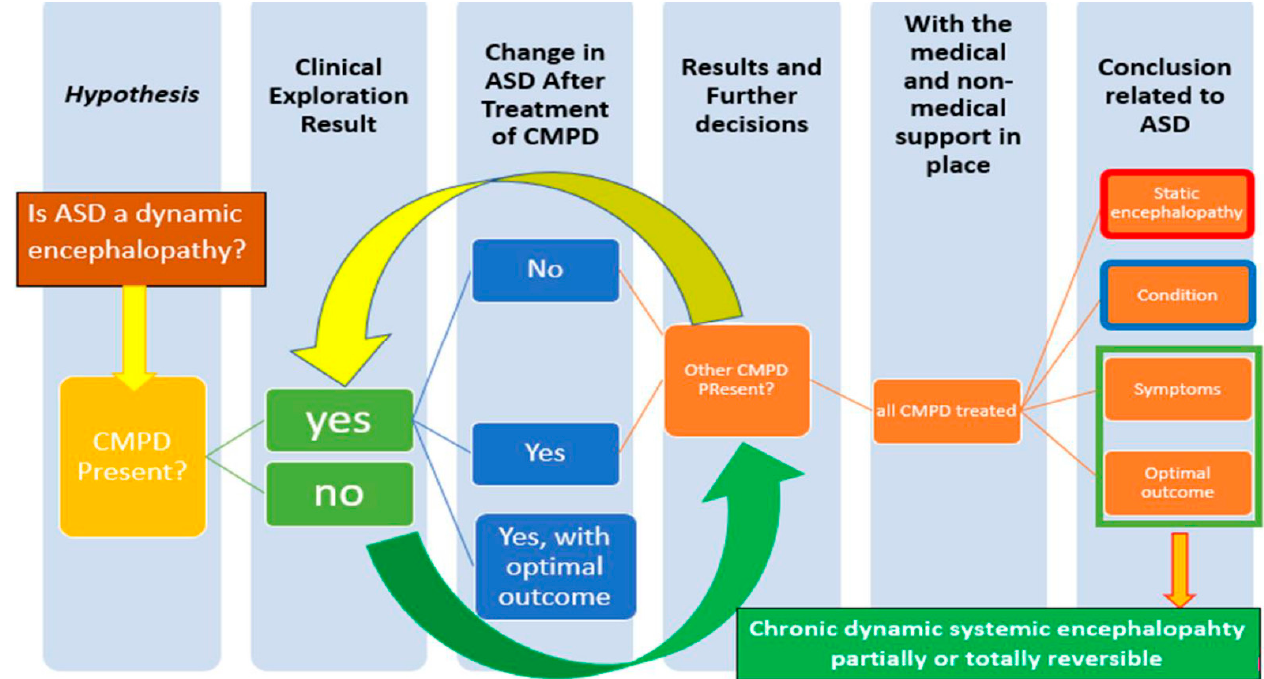
Figure 3. A path for the physician from hypothesis to conclusion in an Advanced Integrative Approach (AIA) of ASD.